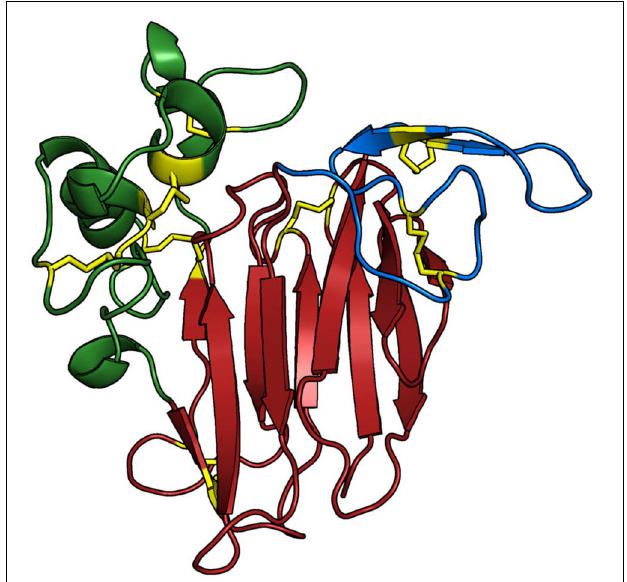
FIGURE 3 | Three-dimensional structure of Gma_P21. The protein structure is coloured based on its domains: (i) domain I ( red ), consisting of a 11 stranded β -sheet organised as a β -barrel that forms the protein core; (ii) domain II ( green ), consisting of an α -helix and a set of disulphide-rich loops; and (iii) domain III ( blue ), presenting a β -hairpin and a coil region, which are both maintained by one disulphide bond each. The main chain of the Osmotin structure is represented as cartoon and the side-chains of the residues involved in disulfide bonds are presented as yellow sticks. The Sni_SnOLP, Sni_SindOLP, Sni_Jami, Gma_OLPb, Gma_P21like, Gma_P21, Gma_OLPc, and Gma_OLPb structures share the same topology. The image was generated with PyMOL Molecular Graphics System version 1.5.0.4 (Schrödinger, LLC).